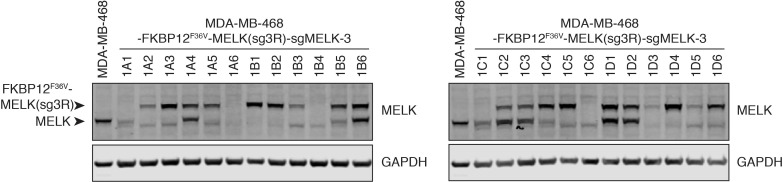
Single clones selected from MDA-MB-468-FKBP12F36V-MELK(sg3R) cells subject to CRISPR/Cas9-mediated knockout of endogenous MELK.Immunoblots for MELK and GAPDH in single cell clones selected from MDA-MB-468-FKBP12F36V-MELK(sg3R) transfected with Cas9/sgMELK-3 to knockout endogenous MELK. Clone 1D4 is clone 1 and clone 1A3 is clone 2 in Figure 4. Clone 1D4 was confirmed with heterozygous −1 and +1 indels; clone 1A3 was confirmed with homozygous −1 deletions.